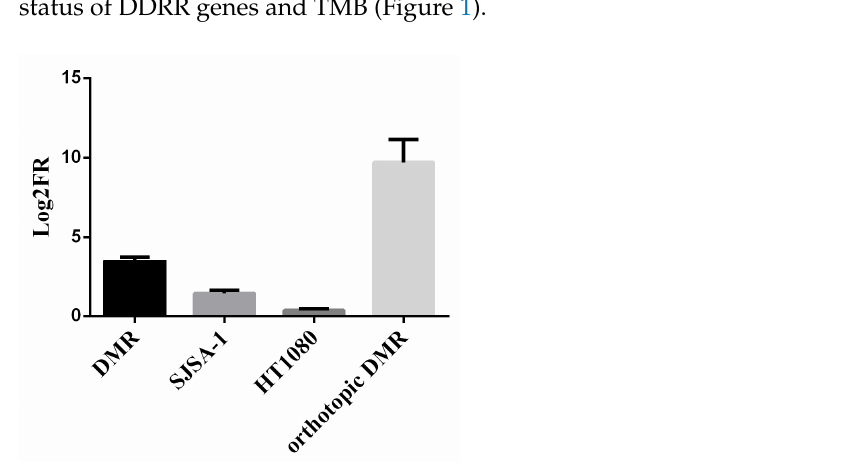
Figure 3. Antitumor effect in DMR, SJSA-1 and HT1080 xenograft models and DMR orthotopic model treated with trabectedin and olaparib combination compared to untreated controls. Five mice per group (control and combination treated) were included in the experiment. Log2FR = Log2 fold-reduction in tumor volume as compared to untreated controls. Results are depicted as mean of Log2FR ± standard deviation.